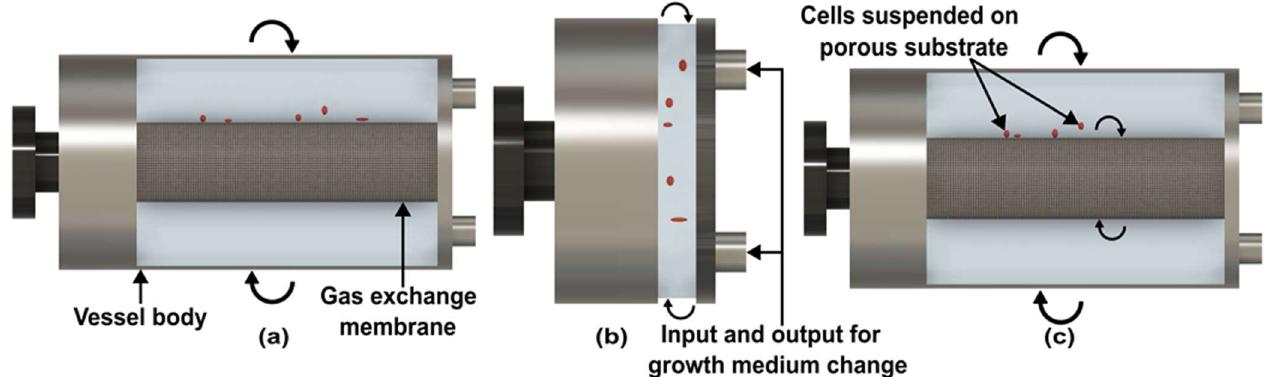
Figure 4. Side-view of rotating wall vessels. ( a ) Slow turning lateral vessel. ( b ) High aspect ratio vessel. ( c ) Rotating wall perfused vessel. (Adapted with permission from [58]. Copyright 2005, Elsevier Ltd.)